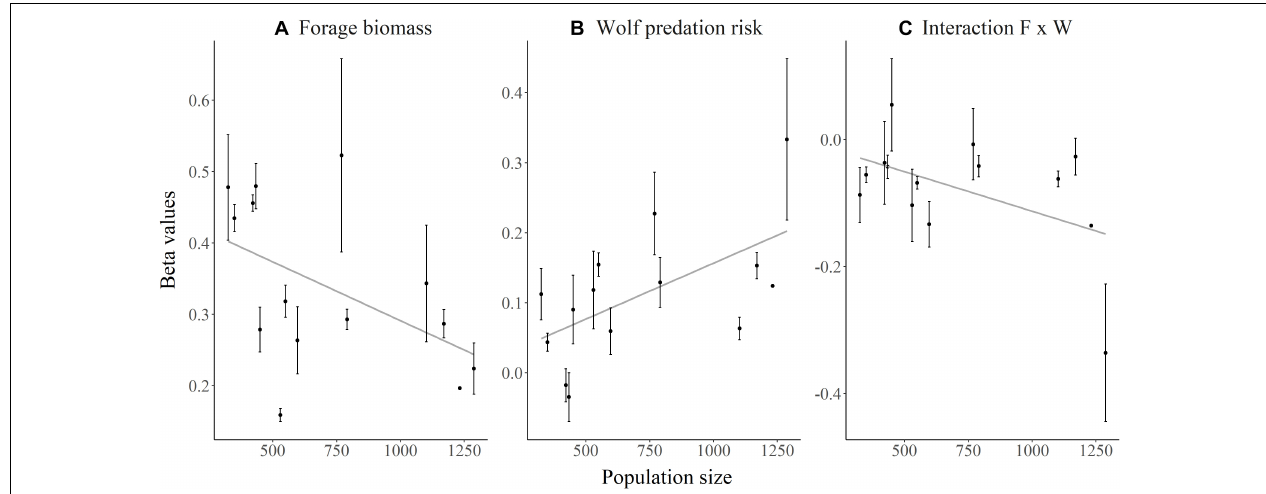
FIGURE 2 | Relationships between elk population size on the Ya Ha Tinda winter range adjacent to Banff National Park in Alberta, Canada, during winters from 2002–2003 to 2015–2016 and the mean selection coefficients ( β ) extracted from each individual elk’s winter selection model for (A) forage biomass, (B) wolf predation risk, and (C) the interaction of forage biomass (F) and wolf predation risk (W). Selection coefficients were derived from diurnal locations of GPS-collared female elk using integrated step selection analysis (details in text). Error bars show ± 1 standard error. No differences ( p > 0.52) occurred in the relationship between selection and elk population size between migrant and resident elk for any